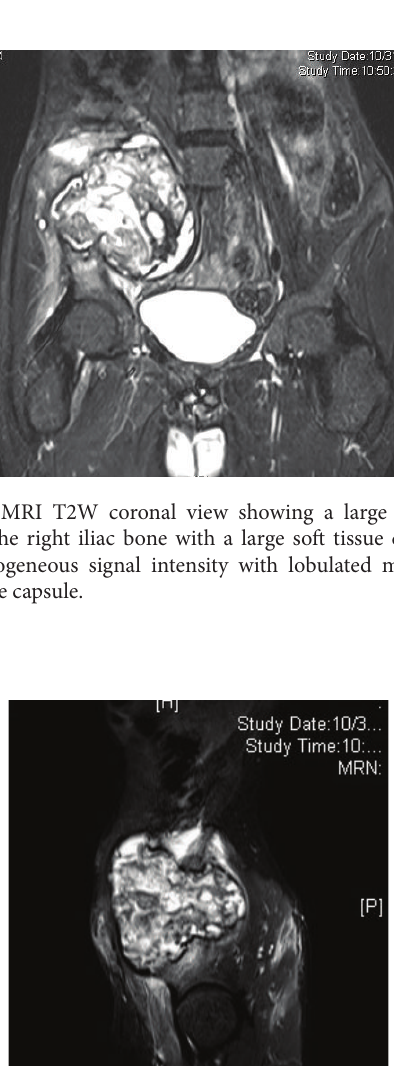
Figure 1: Plain radiograph showing a lytic lesion in the right iliac wing with minimal periosteal reaction.